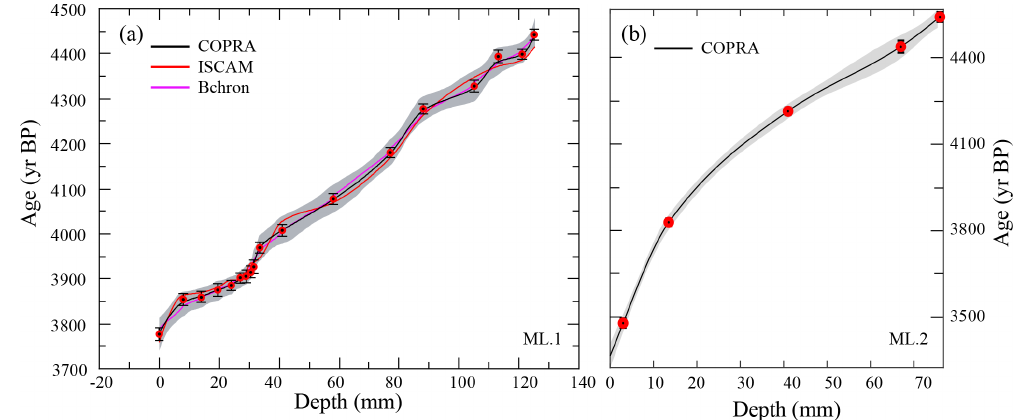
Figure 4. Age models of ML.1 and ML.2 records. We adopted COPRA and generated 2000 realizations of age models to account for the dating uncertainty (2.5% and 97.5% quantile) confidence limits. (a) ML-1 age models and modeled age uncertainties using three different age modeling algorithms: COPRA (black) (Breitenbach et al., 2012), Bchron (purple) (Haslett and Parnell, 2008), and ISCAM (red) (Fohlmeister, 2012). The gray band depicts the 95% confidence interval using COPRA. Error bars on 230 Th dates represent a 2 σ analytical error. (b) ML.2 age model and modeled age uncertainties using